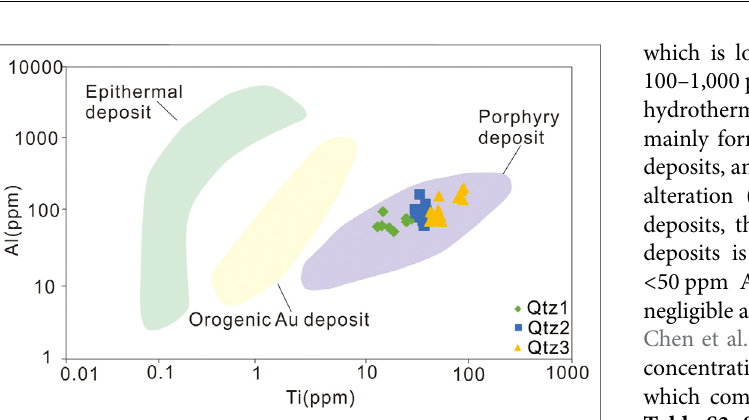
FIGURE 10 | Structure sketch and the temperature changes before and after resorption of quartz phenocrysts from the Hongniu – Hongshan deposit.